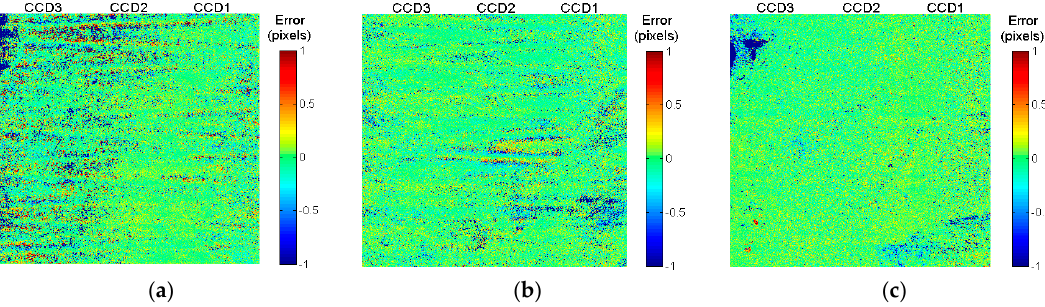
Figure 10. Parallax images between B1 and B2 along the track of ( a ) Scene A, ( b ) Scene B, and ( c ) Scene C.